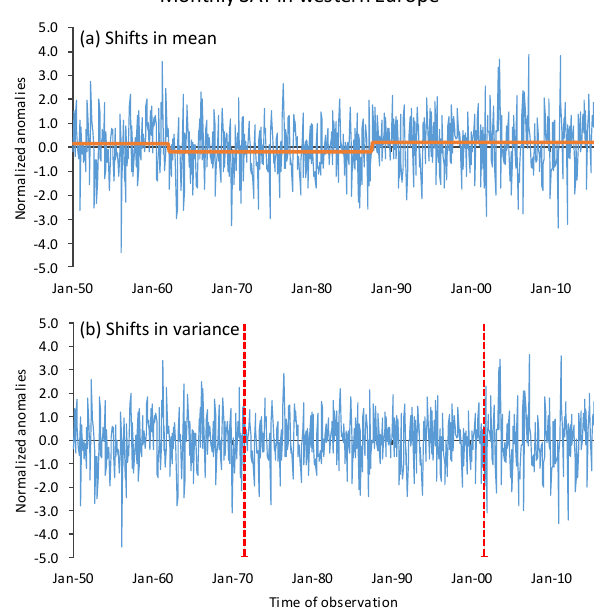
Figure 11. (a) Normalized (by standard deviations) monthly sur- face air temperature (SAT) anomalies in western Europe (45–50 ◦ N, 0–10 ◦ E) and regime shifts in the mean detected by SRSD (0.05, 120, 2). The change points are February 1962 and August 1987; (b) Residuals after removing the stepwise trend in the mean and regime shifts in the variance detected by SRSD (0.1, 120, 2) and ICSS. The change points are July 1971 and September